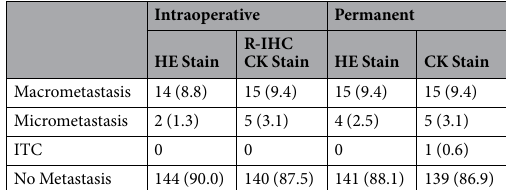
Table 3. Comparison of intraoperative and permanent pathological diagnoses of sentinel lymph